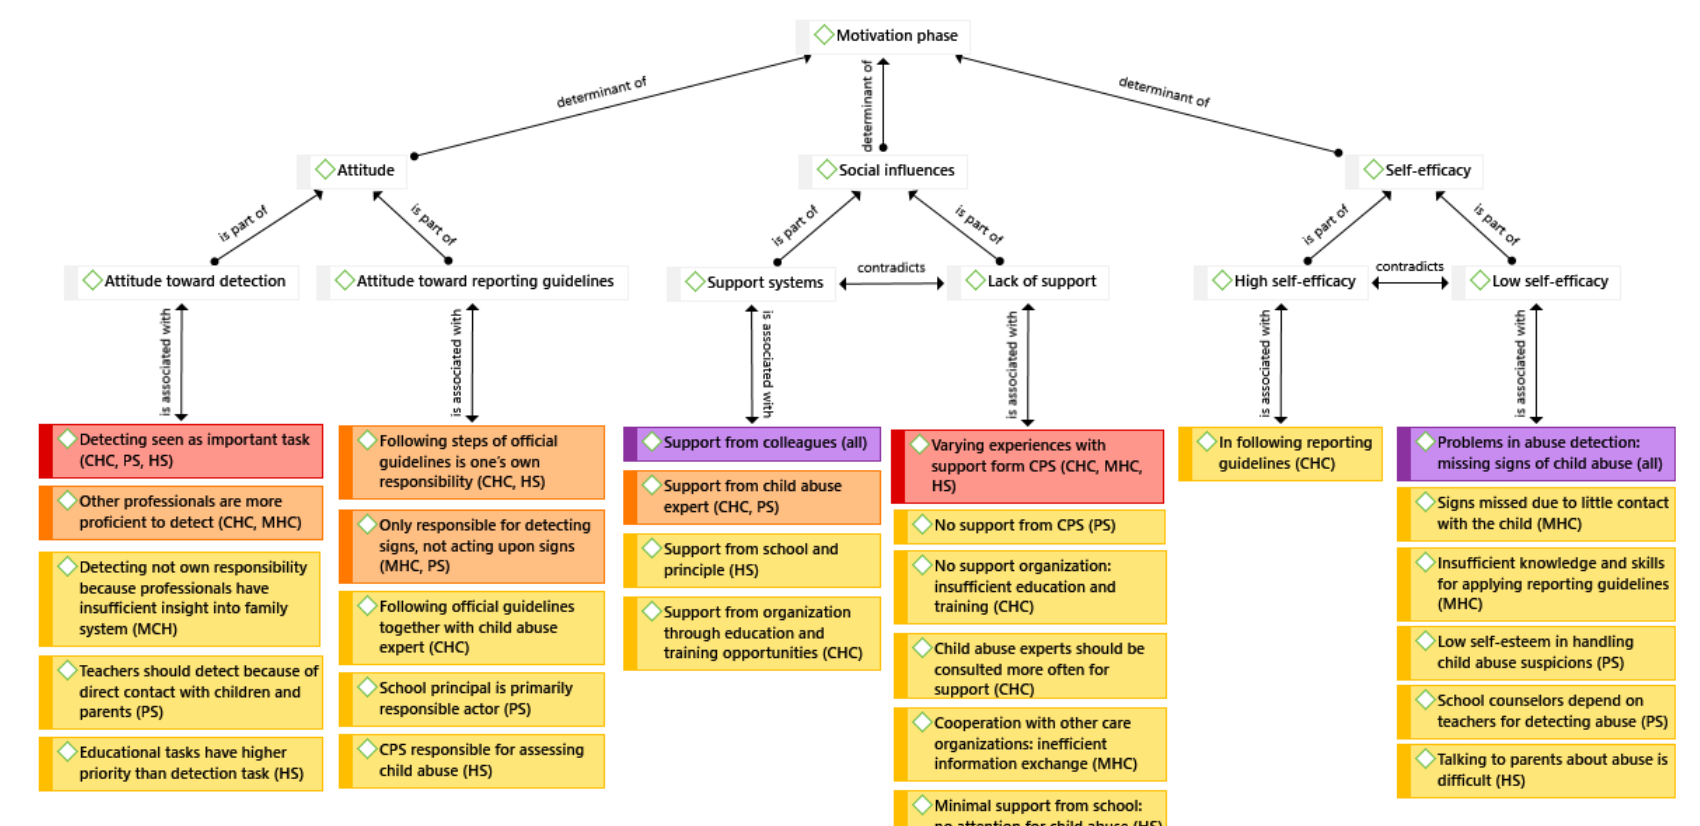
Figure 2. A concept map of the results as related to the motivation phase of the I-Change model. The labels on the second level refer to the determinants of the motivation phase, the labels on the third level refer to the key themes, and the labels on the fourth level refer to the subthemes. Subthemes with purple labels are relevant for all groups of professionals, subthemes with red labels are relevant for three groups, subthemes with orange labels for two groups, and subthemes with yellow subtheme for one group of professionals. The specific groups of professionals for which the subthemes were applicable, are presented in parentheses. CHC = child health care professionals; MHC = mental health care professionals; PS = primary school professionals; HS = high school professionals.